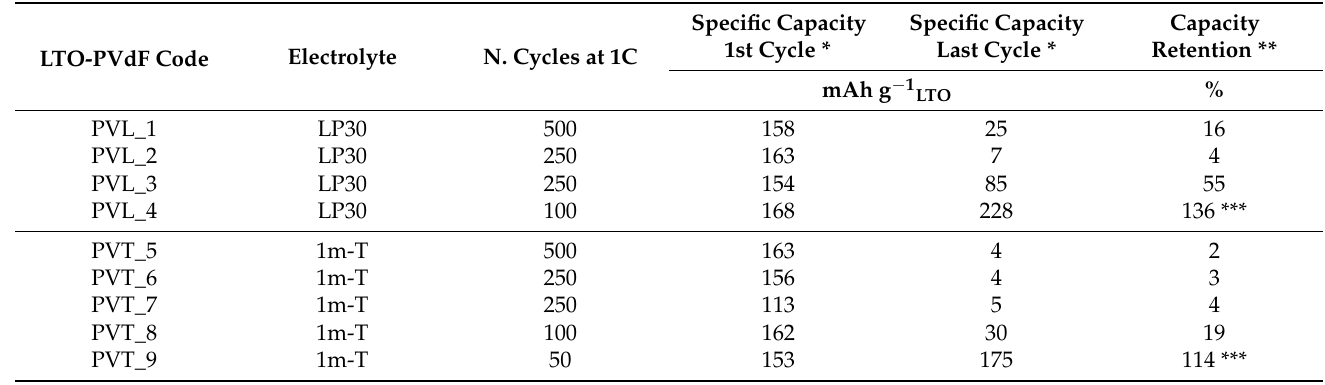
Table 4. Specific capacity (mAh g − 1 LTO ) during de-lithiation process at the first and last cycle at 1C and capacity retention of LTO-PVdF tested in LP30 and